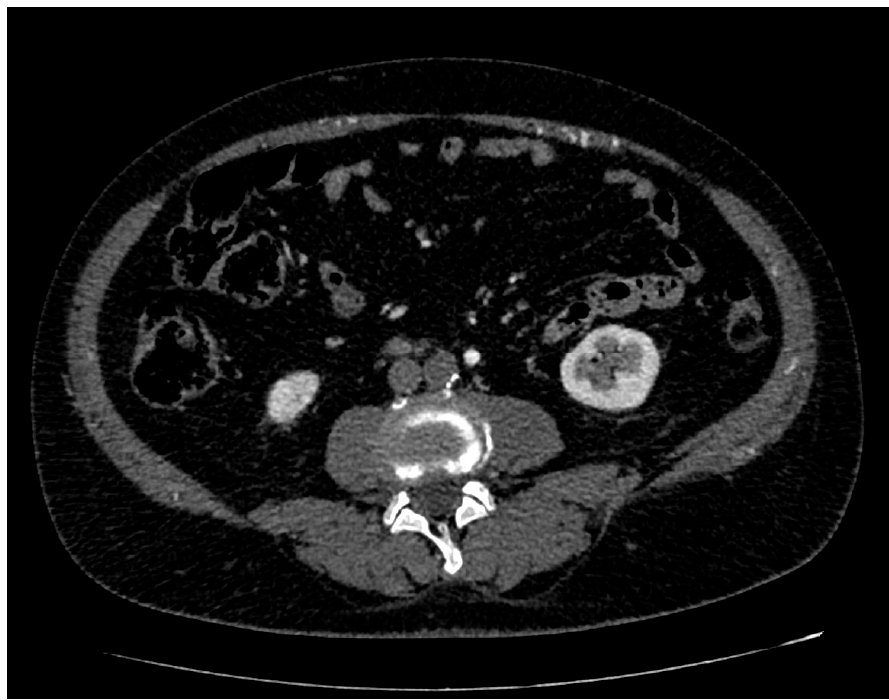
Figure 1. CT angiography, axial planes, arterial phase. The mesenteric inferior artery and its branches are normally enhanced while the aorta is completely occluded, in absence of signs of aneurysms and dissection.